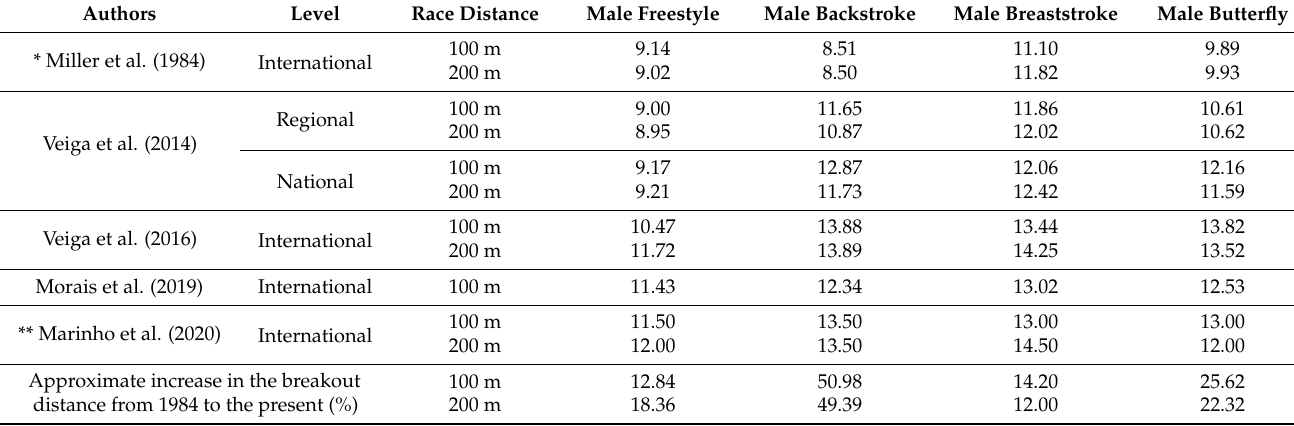
Table 2. Breakout distance after the start in the four swimming strokes in 1984 and recent years in male events (the numbers in the table only show the mean value presented in each study).